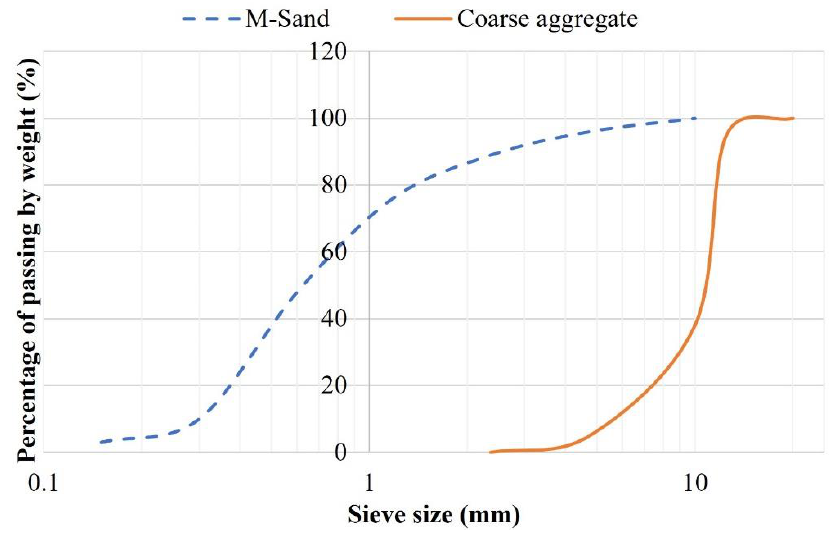
Figure 1. Particle size distribution of M-Sand and coarse aggregates.